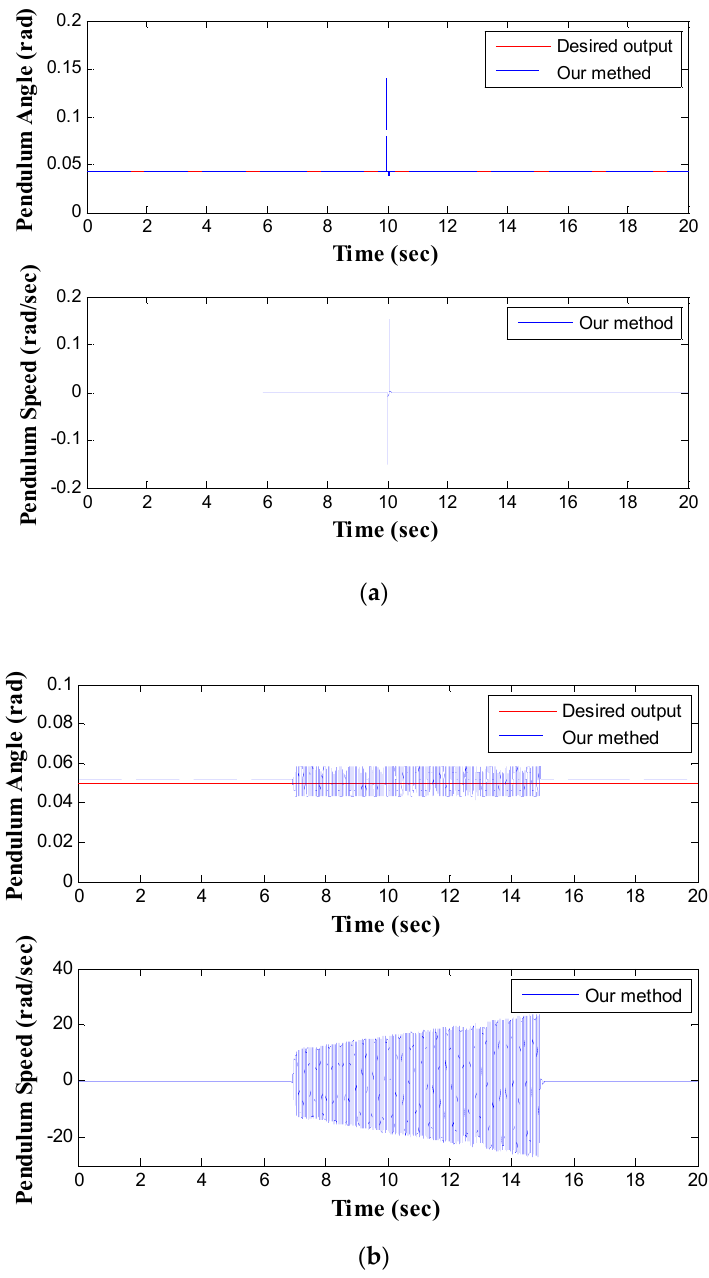
Figure 14. ( a ) The effect of one impulse noise, ( b ) the effect of a change in plant dynamics.